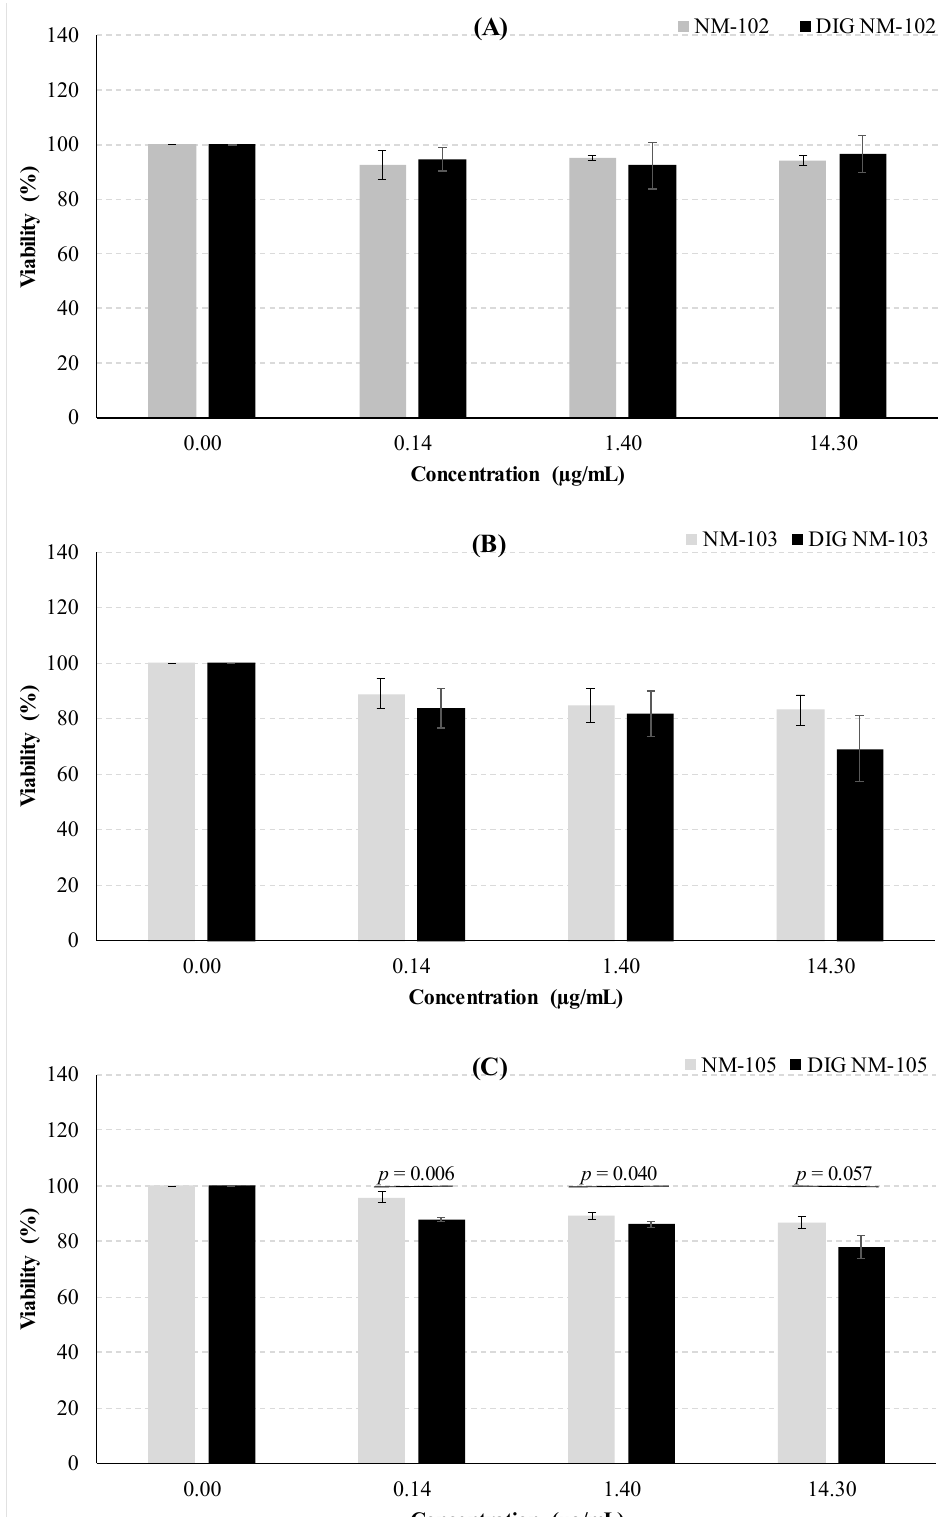
Figure 5. Analysis of the cytotoxic effects in HT29-MTX-E12 cells, 24 h after exposure to the undigested and digested (DIG) NMs: ( A ) NM-102, ( B ) NM-103 and ( C ) NM-105.